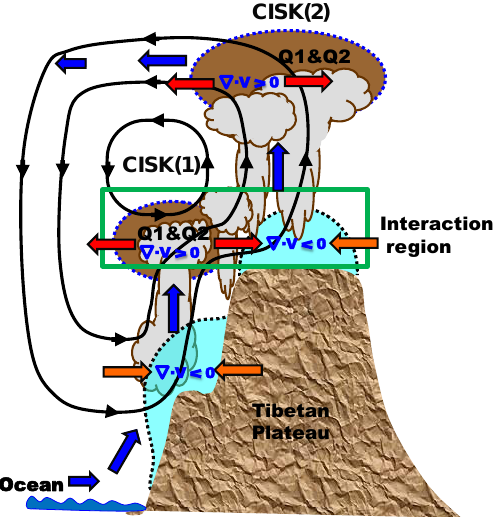
Figure 7. A diagram of the summary on two ladders of CISK-like processes with two couplings of heat source Q 1 and moisture sink Q 2 over the TP’s southern slopes and main platform in forcing wa- ter vapor flows climbing up the TP, which is marked with soil